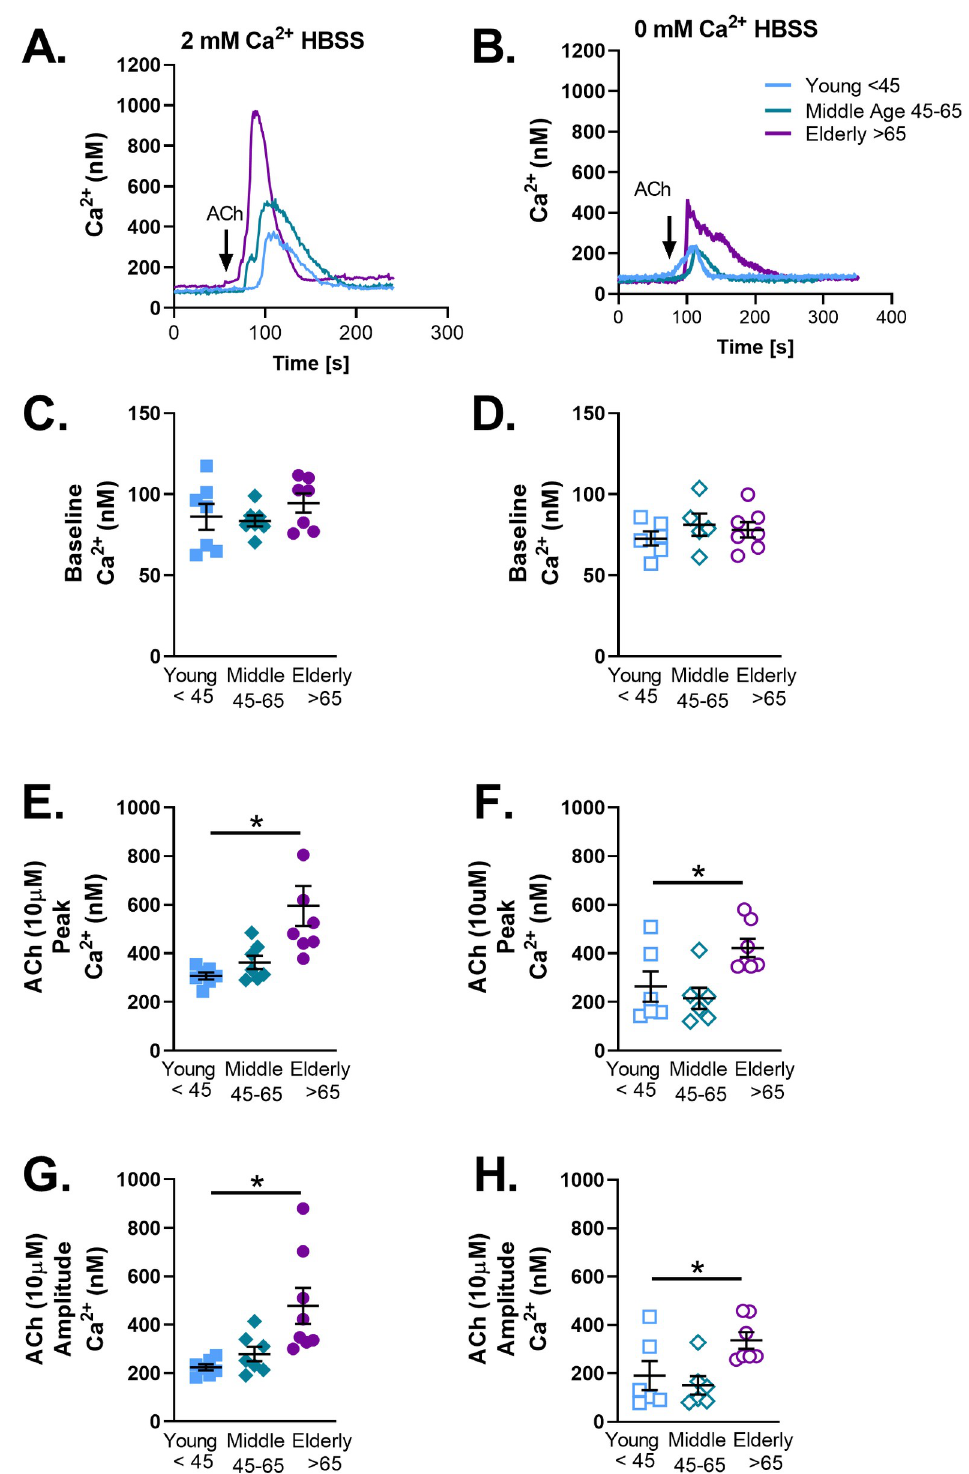
Fig 5. Acetylcholine-induced [Ca 2+ ] i in aging human ASM cells. Representative tracings in young < 45, middle age 45–65, and elderly > 65 human ASM (A&B). ACh (10 μ M, black arrow) was applied to Fura 2 AM loaded cells in 2 mM Ca 2+ HBSS. Baseline intracellular calcium was not changed (C). Peak (E) and amplitude (G) of [Ca 2+ ] i was increased in elderly ASM. To measure changes in [Ca 2+ ] i release following contractile agonist stimulation independent of Ca 2+